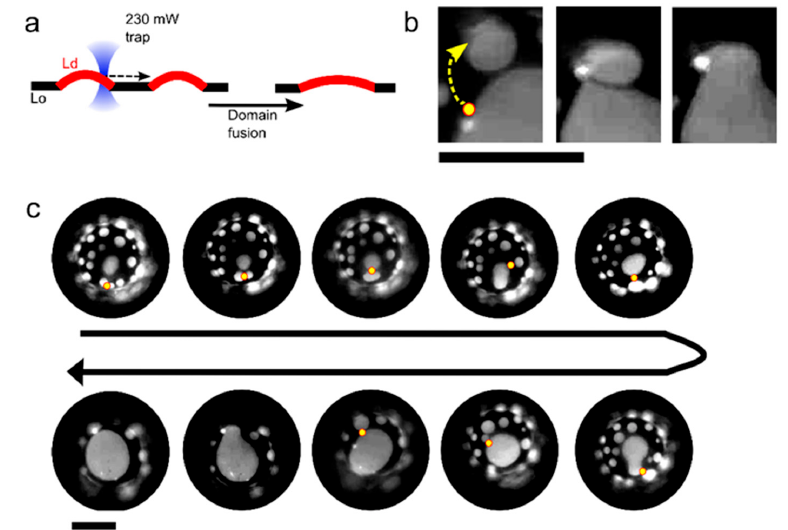
Figure 3. Controlled manipulation of membrane domains using optical traps. ( a ) Schematic showing manipulation of liquid-disordered (L d ) domains within a liquid-ordered (L o ) matrix to induce domain fusion. ( b ) Fluorescence image of a portion of a vesicle membrane showing an L d domain being dragged by an optical trap (yellow dot and arrow) towards an adjacent domain to induce fusion. Lipid composition: DOPC / EggSM / Chol 1:1:1. ( c ) Time-course image showing eight sequential fusion events that were user-defined through domain manipulation with an optical trap (yellow circle). Scale bars = 5 µ